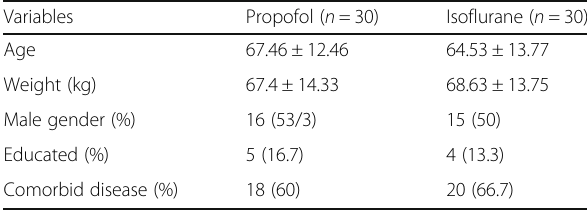
Table 1 General characteristics of study participants (percentage or mean ± SD) Variables Propofol ( n = 30)